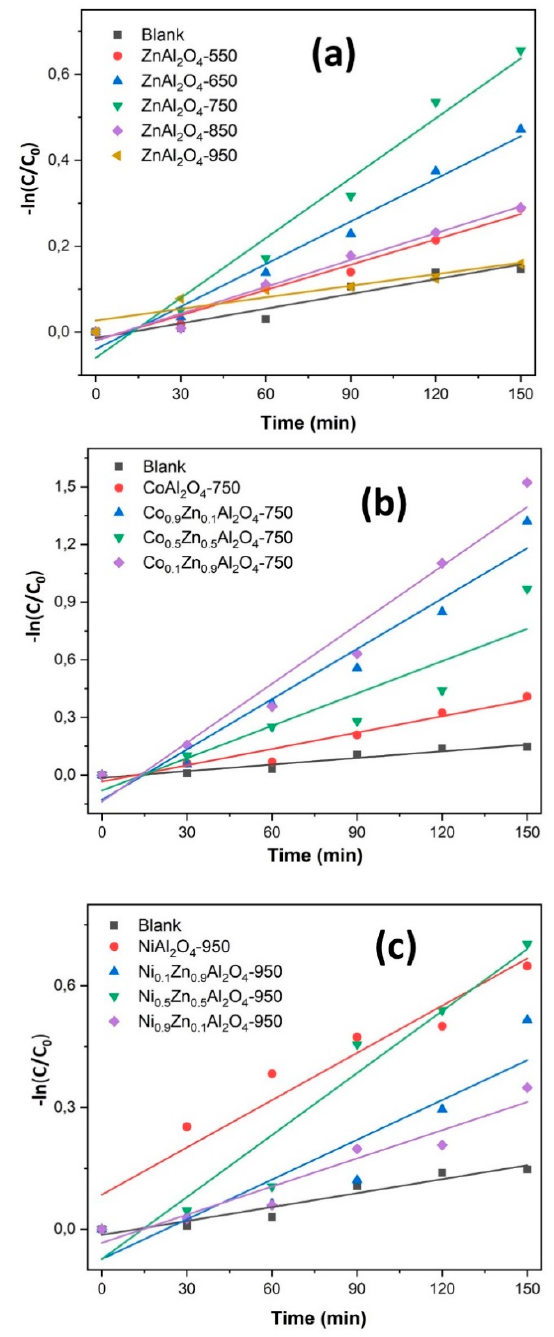
Figure 8. Rhodamine B photocatalytic degradation kinetics for samples: ZnAl 2 O 4 –550, ZnAl 2 O 4